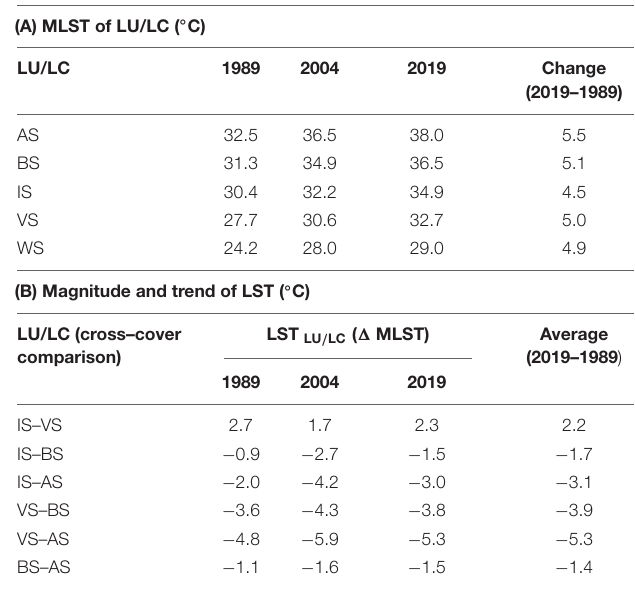
TABLE 5 | Mean LST of LU/LC and their magnitude and trend of SUCIIIS–GS ( ◦